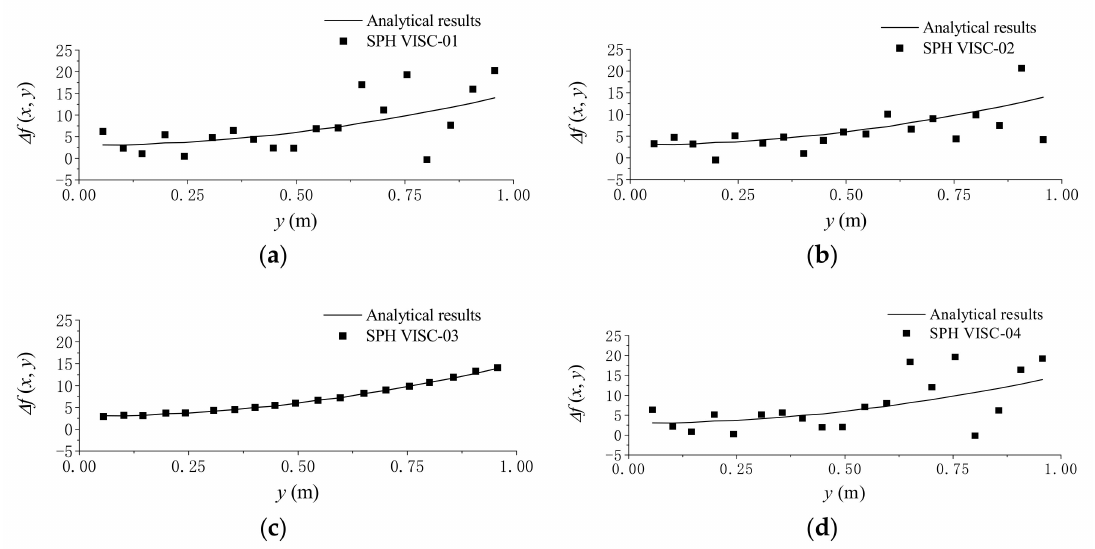
Figure 4. Comparisons of analytical and numerical results computed by using different viscosity force models with the non-uniform particle distribution: ( a ) VISC-01; ( b ) VISC-02; ( c ) VISC-03; and ( d )